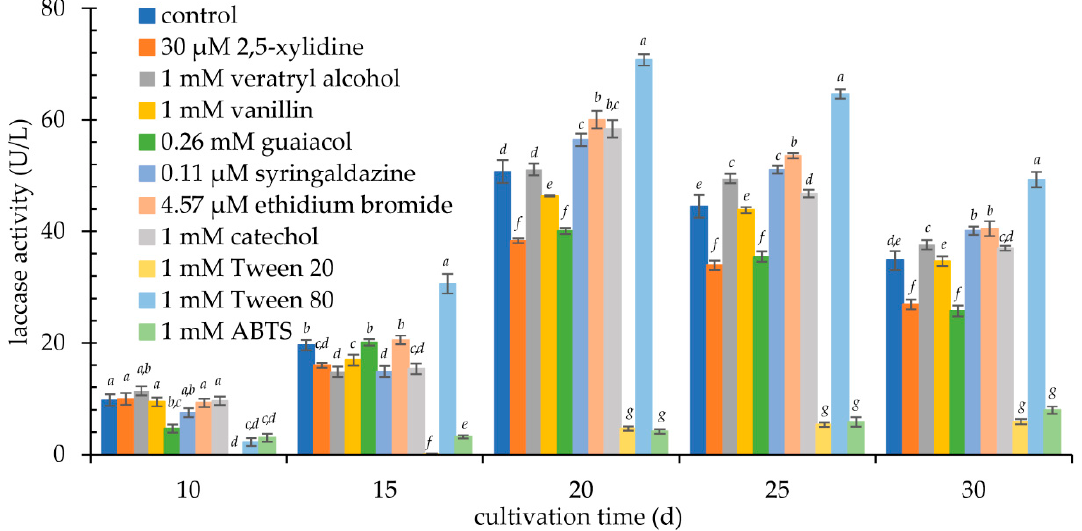
Figure 5. Influence of inducers (at the optimal concentration) on extracellular laccase activity (U/L) during 30-day culture; The data presented as the means ± SD from at least three independent experiments; the means within single culture day that are marked with different letters ( a – g ) are significantly different.